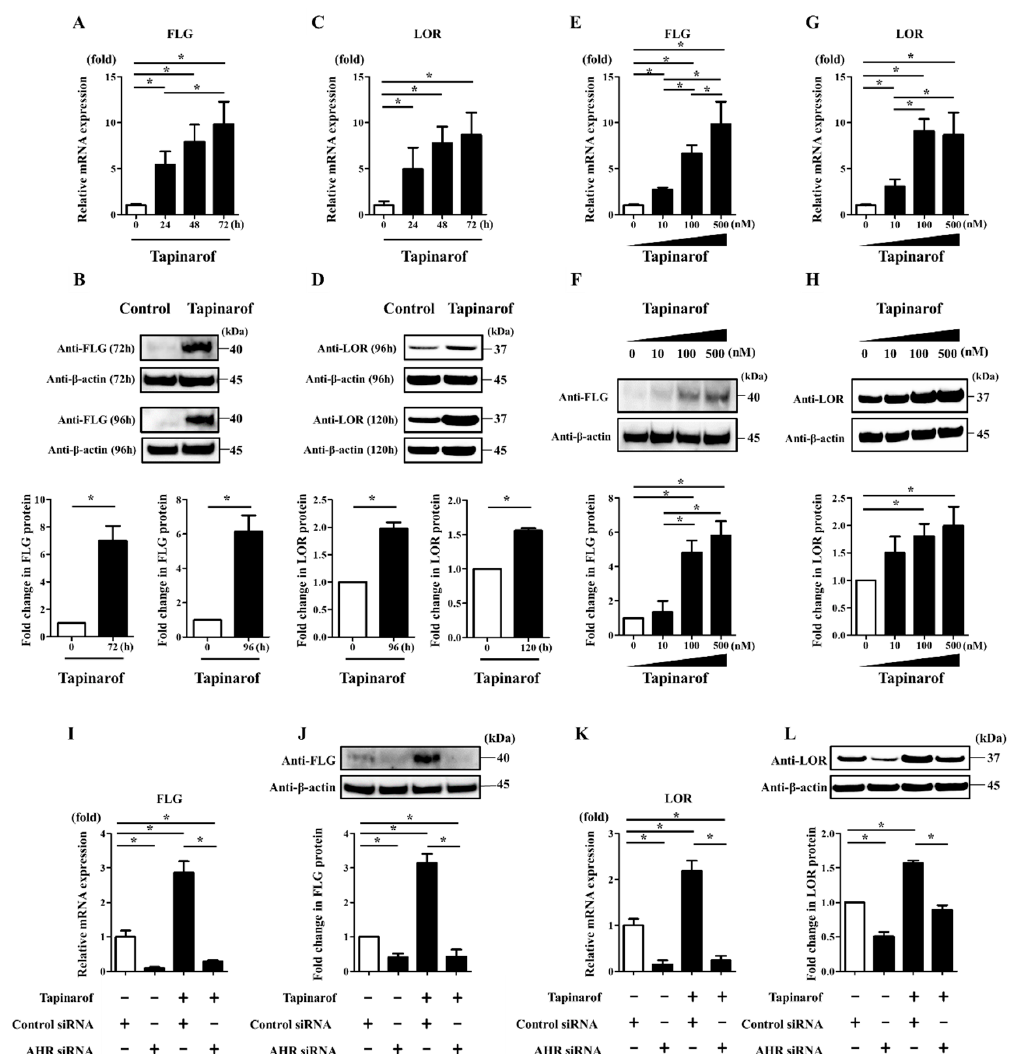
Figure 1. Tapinarof upregulated FLG and LOR expression via AHR activation in NHEKs. ( A – D ) NHEKs were treated with tapinarof (500 nM) for the indicated period. ( E – H ) NHEKs were treated with tapinarof at the indicated dose, ( I – L ) si-control- and si-AHR-transfected NHEKs were treated with tapinarof (500 nM) for 72 h for qRT-PCR and for 96 h for Western blotting analyses. ( A , C , E , G , I , K ) FLG and LOR mRNA expression was assessed by qRT-PCR. Representative data of three independent experiments with similar results are shown. ( B , D , F , H , J , L ) FLG and LOR protein expression was analyzed by Western blotting with anti-FLG and anti-LOR antibodies. ( Upper ) Representative blot images of three independent experiments with similar results are shown. ( Lower ) FLG or LOR protein levels are normalized to β -actin protein levels using ImageJ and expressed as fold change over the control group. ( A – L ) Error bars represent mean ± standard deviation; n = 3 for each group. Statistically significant differences are presented: * p < 0.05.